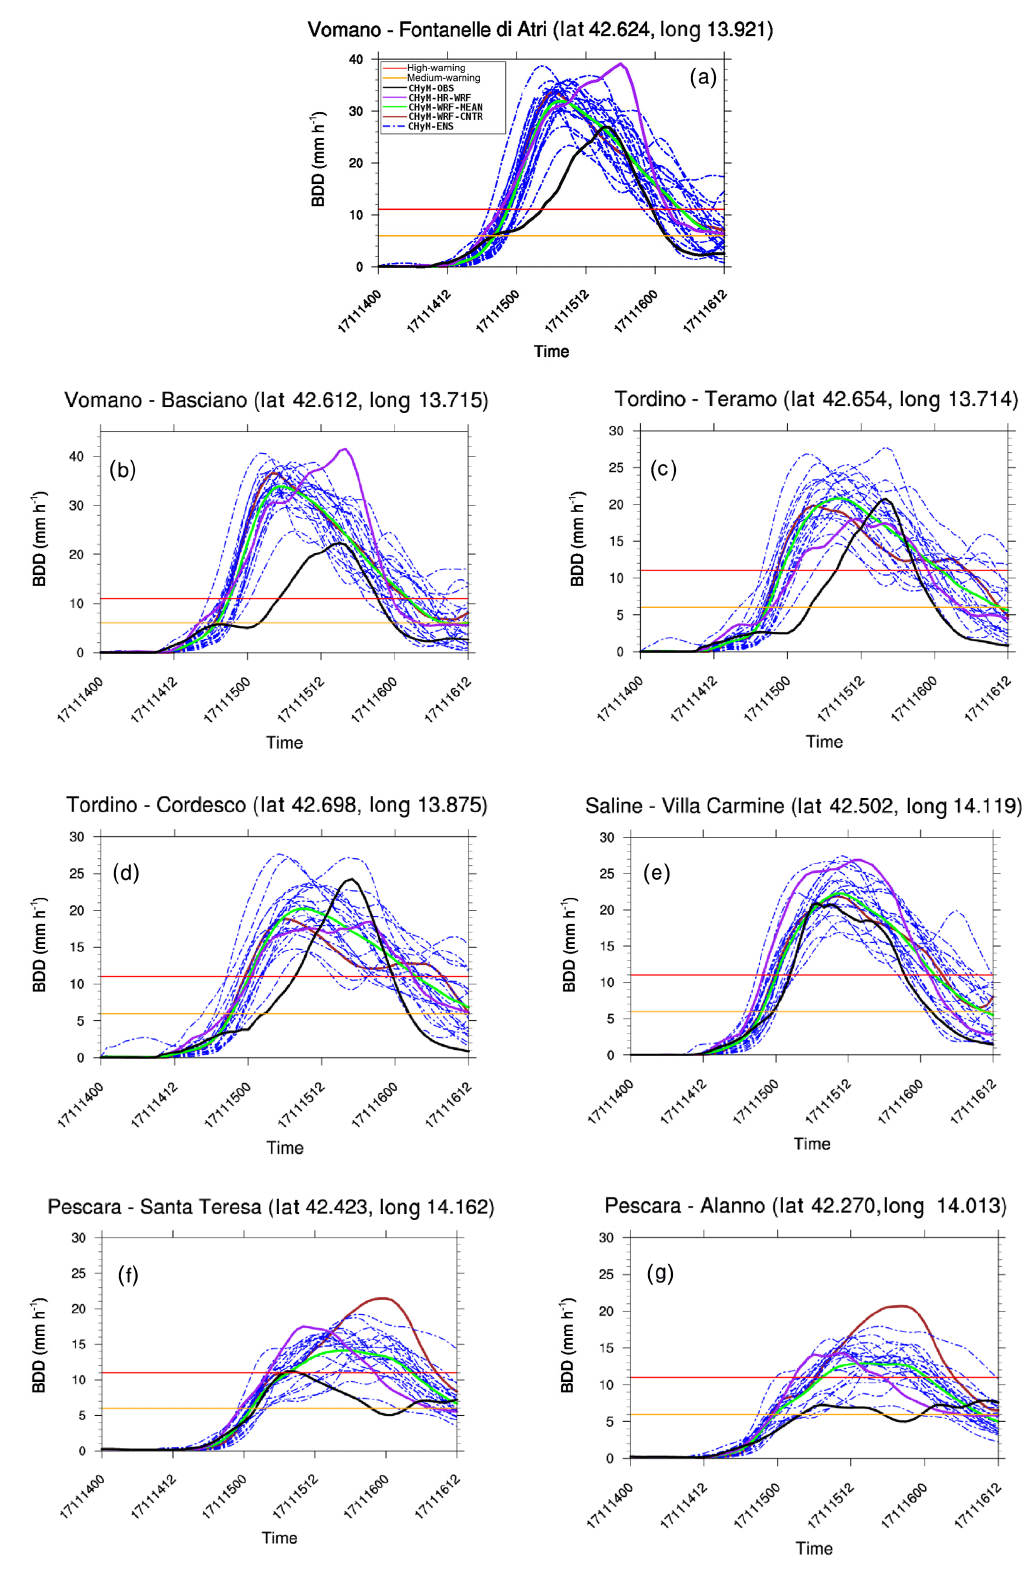
Figure 13. BDD time series (time given in the format of day, month, two-digit year and hour) for catchments of Vomano, Tordino, Saline and Pescara at stations (a) Fontanelle di Atri (Vomano), (b) Basciano (Vomano), (c) Teramo (Tordino), (d) Cordesco (Tordino), (e) Villa Carmine (Saline), (f) Santa Teresa (Pescara) and (g) Alanno